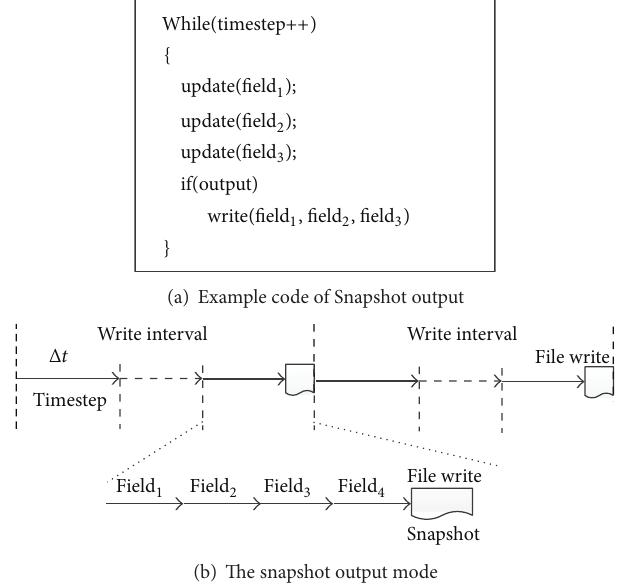
Figure 1: Example code and snapshot output mode of a typical CFD